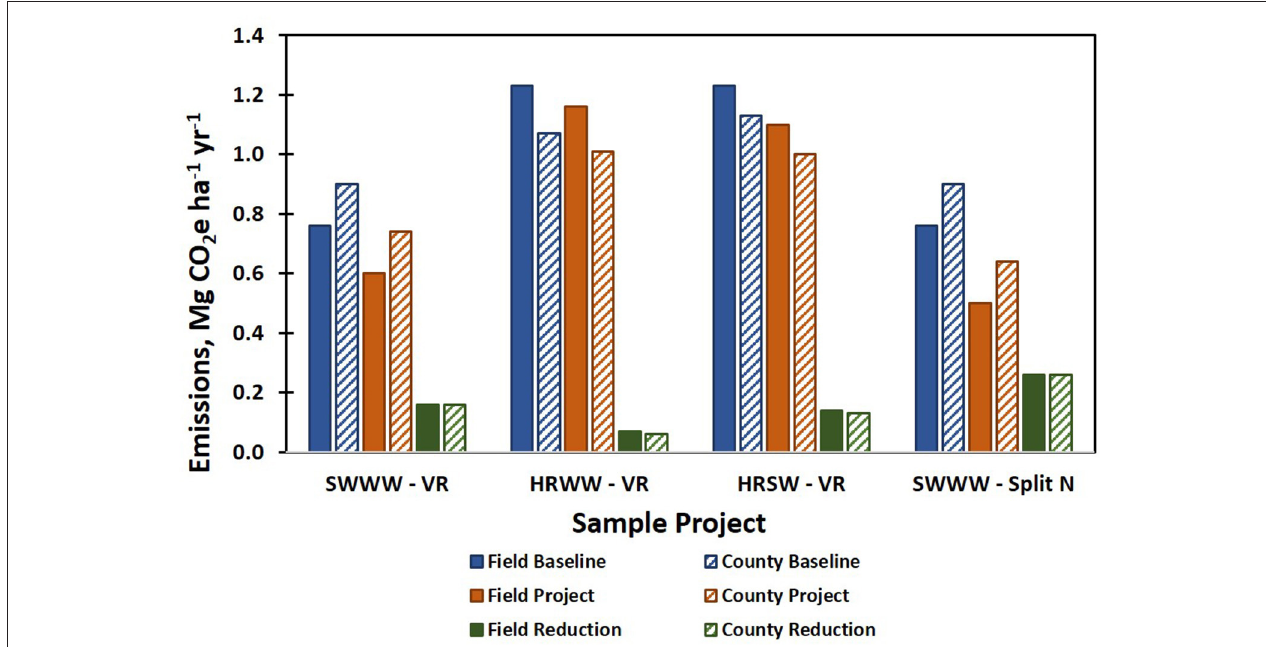
FIGURE 3 | Comparison of Baseline, Project and Offset (Reduction) Emissions Using Field Specific or County Level Data to Determine Baseline Emissions. American Carbon Registry Quantification Methodology, Tier I IPCC direct emission factor and IPCC default indirect emission factors used. Field specific N application records from CAF-LTAR were used to determine N 2 O emission reductions from management changes for: SWWW-VR, soft white winter wheat uniform to variable rate N (Sample Project 1); HRWW-VR, hard red winter wheat uniform to variable rate N (Sample Project 2); HRSW-VR, hard red spring wheat uniform to variable rate N (Sample Project 3); and SWWW-Split N from all fall to split N application between fall and spring (Sample Project